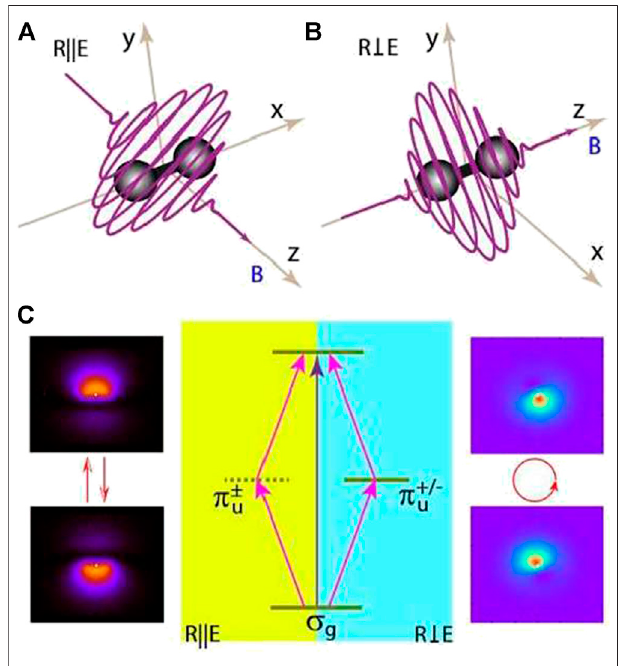
FIGURE 1 | Illustration of ultrafast magnetic fi eld generation B under resonant excitation of H + 2 aligned along the x / z axis by bichromatic co- and counter-rotating circularly polarized XUV pulses E ( t ) with their fi eld vectors polarized in the ( x , y ) plane. Two excitation processes for the molecule axisparallelandperpendiculartothelaser( x , y )polarizationplane,thatis, (A) in plane R (cid:3) E and (B) around axis R ⊥ E , are compared. (C) Molecular σ g − π ± u resonant excitation and ionization are shown for different molecular alignments, and corresponding evolutions of coherent electron wave packet density distributions at different times. Protons are at ± R/2 (cid:1) ± 1